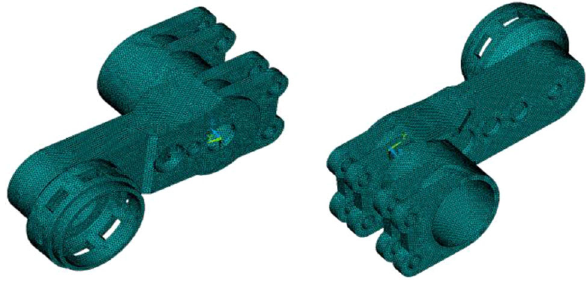
Fig. 9 Finite element model of the